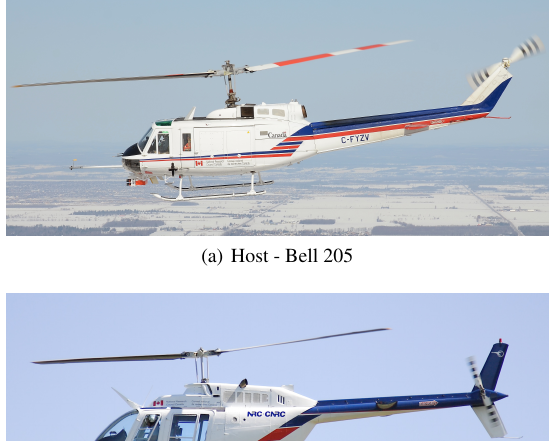
Figure 4: Modeled temporal VHP for collision course targets at different relative altitudes to the host platform. Nominal altitude was set to 1000 ft. “Target Miss Distance” indicates the altitude differential in metres between the host and each